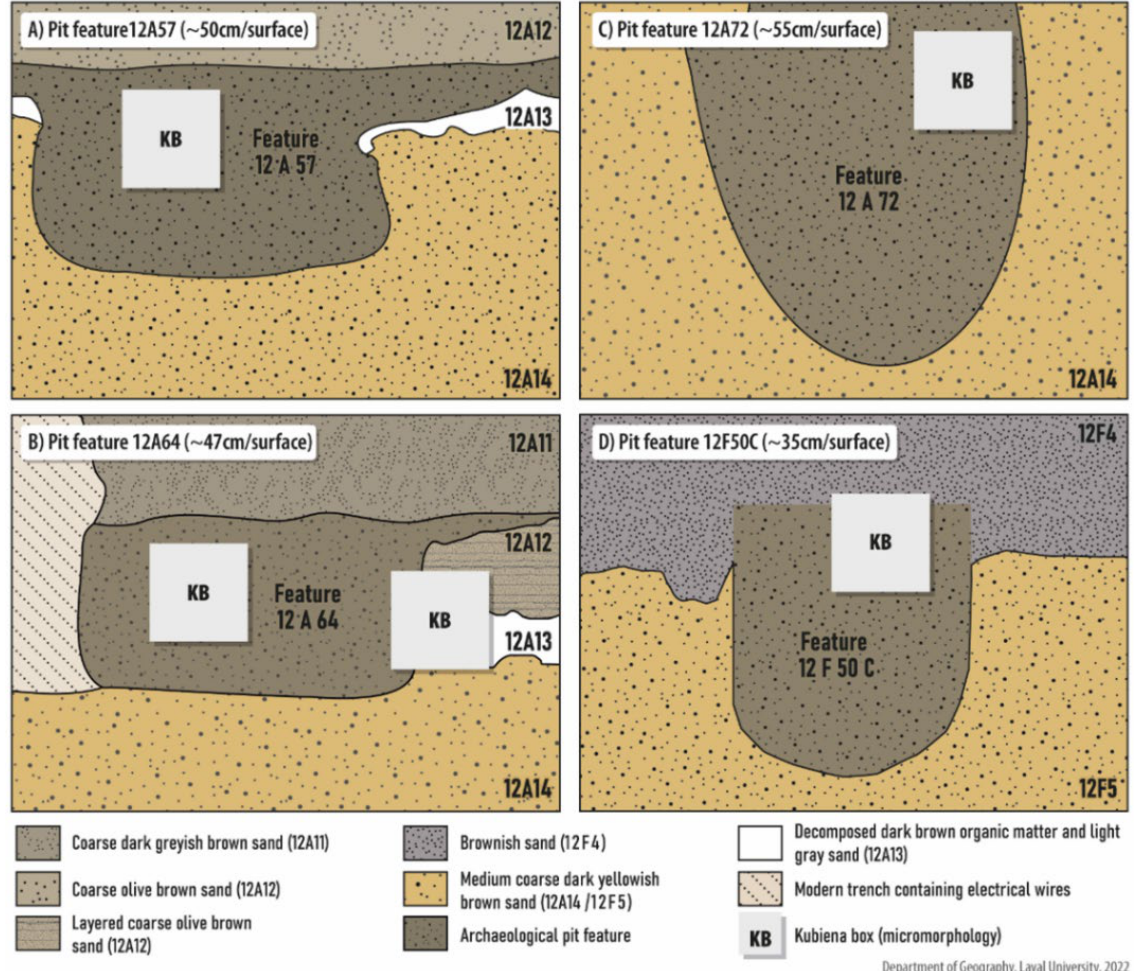
Figure 6. Stratigraphic representation of pit features sampled at the Fort Odanak site (CaFe-7). ( A ) Profile of pit feature 12A57 ( ⁓ 50 cm/surface) ( B ) Profile of pit feature 12A64 ( ⁓ 47 cm/surface) ( C ) Plan view of pit feature 12A72 ( ⁓ 55 cm/surface). ( D ) Profile of pit feature 12F50C ( ⁓ 35 cm/surface).